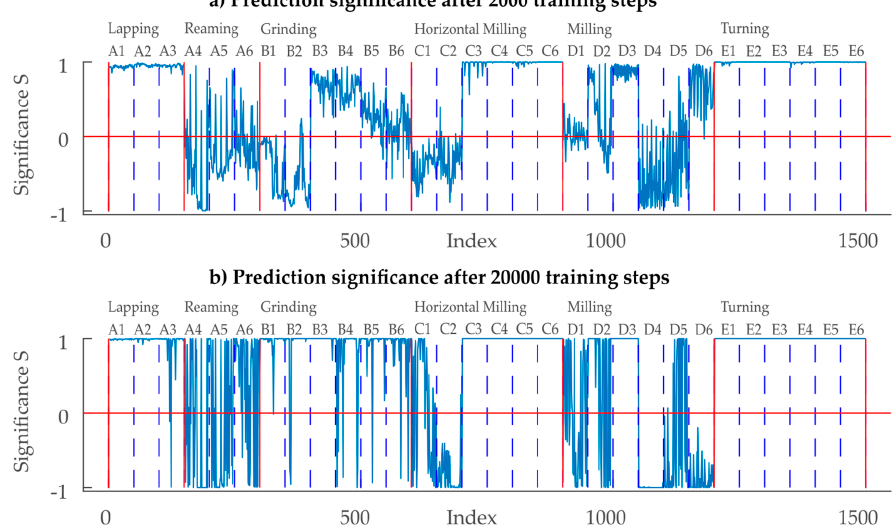
Figure 10. Prediction significance of the CNN trained with the full set of training data A1–E6: Positive values display the difference to the 2nd largest significance of the SoftMax layer. Negative values display the difference from the largest SoftMax significance level to the level of the true class.